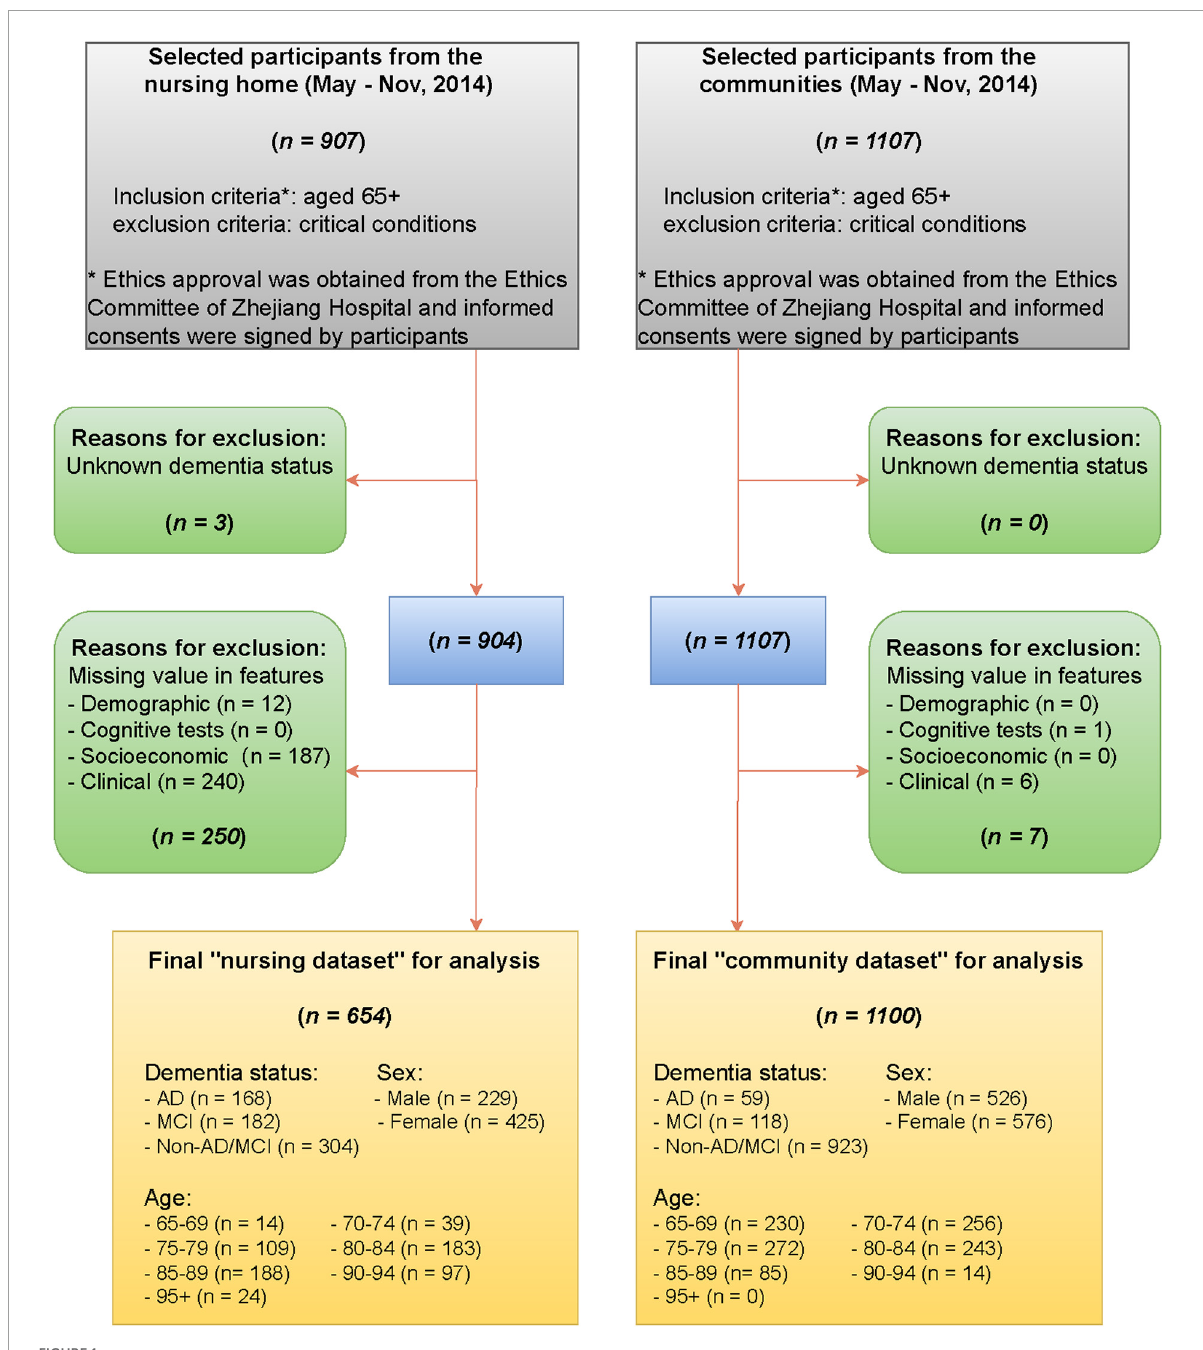
FIGURE1 Flow diagram of selecting participants from the nursing home and the communities.